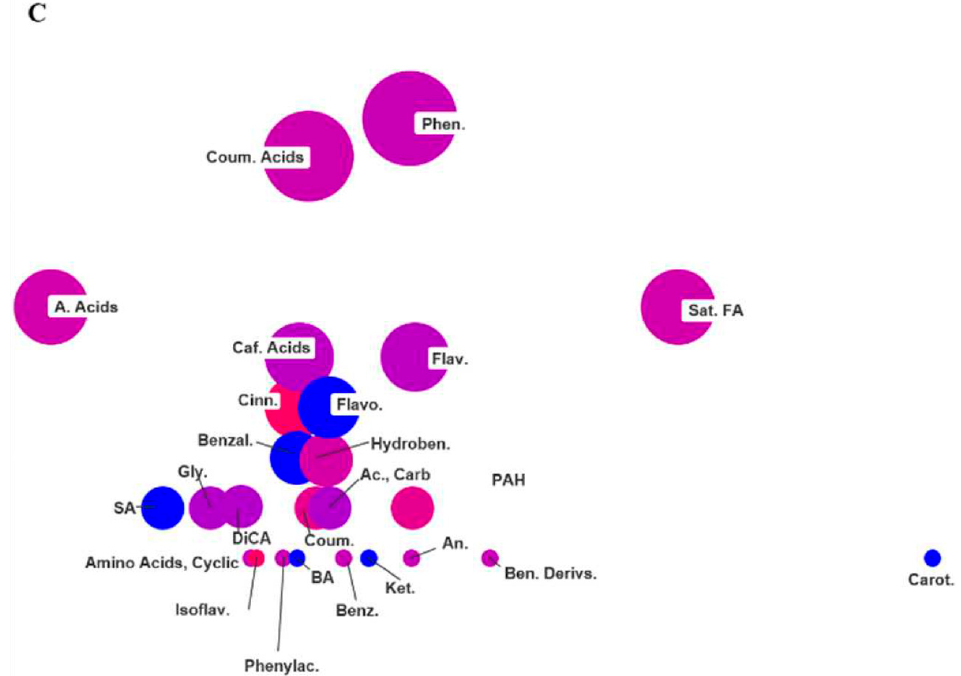
Figure 5. Chemical similarity enrichment analysis (ChemRICH diagrams) of the metabolites found in plants under Fe deficiency ( A ), S deficiency ( B ) and dual deficiency ( C ), as obtained by UHPLC/QTOF-MS and GC-MS. Color is according to proportion of increased or decreased compounds (red = increased, blue = decreased, pink = mixed) within each cluster. A. Acids: amino acids; Ac., Carb.: Acids, Carbocyclic; An.: anisoles; BA.: Benzyl Alcohols; Ben. Derivs: benzene derivatives; Benz.: benzoates; Benzal.: benzaldehydes; But.: butyrates; C.-A. Acids: Amino AcidsCyclic; Caf. Acids: caffeic acids; Carot.: carotenoids; Cinn.: cinnamates; Coum. Acids: coumaric acids; Coum.: coumarines; DiCA.: dicarboxylic acids; Flav.: flavonoids; Flavo.: Flavones; Gly.: glycols; Hydroben.: hydroxybenzoates; Isoflav.: Isoflavone; Ket.: Ketones; PAH.: Polycyclic Aromatic Hydrocarbons; Phen.: phenols; Phenylac.: phenylacetates; SA.: Sugar Alcohols; Sat. FA.: saturated fatty acids.